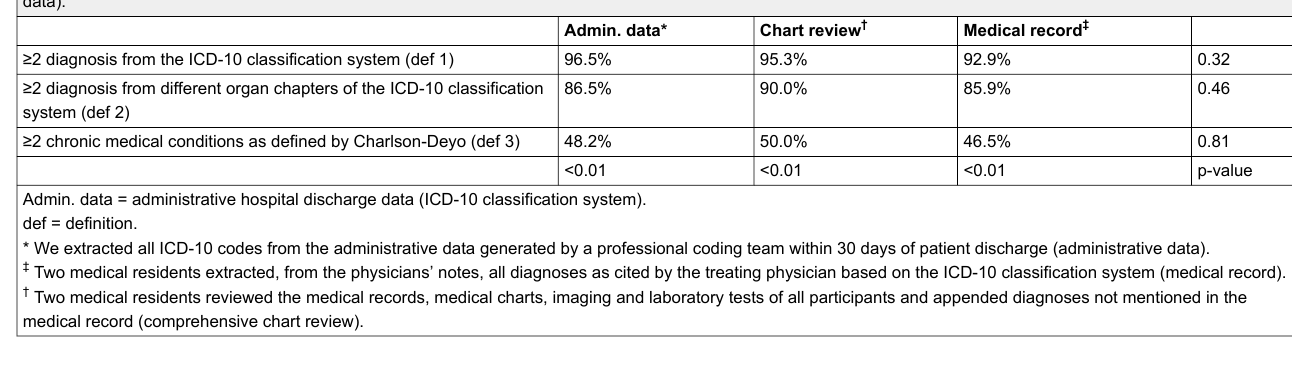
Table 3: Prevalence of multimorbidity based on three different definitions of multimorbidity and three different data sources (medical record, chart review, administrative data).